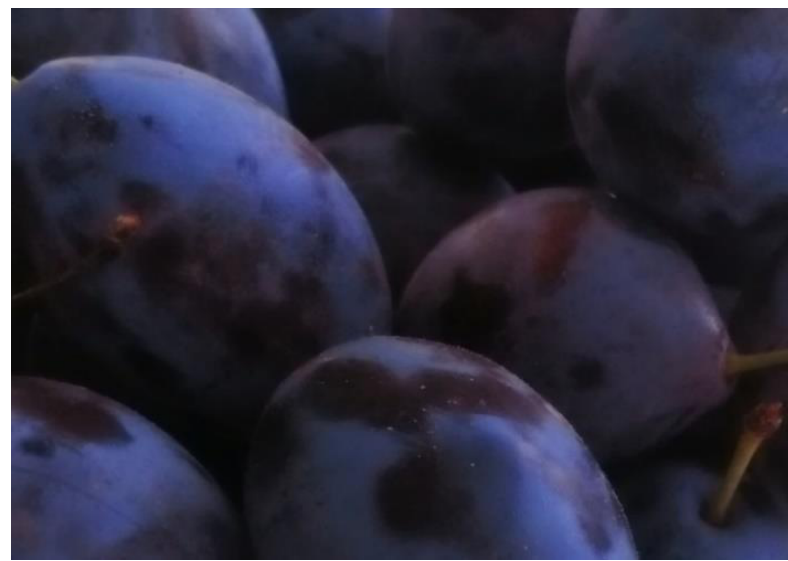
Figure 2. Representative Illustration of a Bunch of Plums.